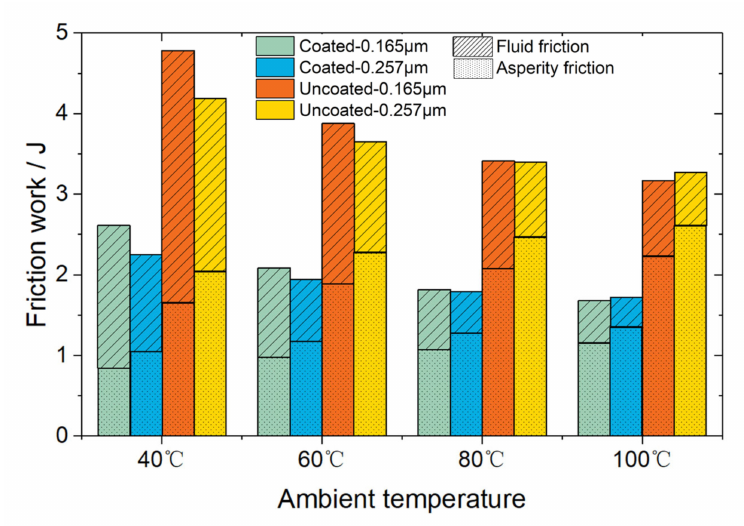
Figure 14. The friction work for di ff erent surface conditions at various ambient temperatures in a cam cycle under the heavy